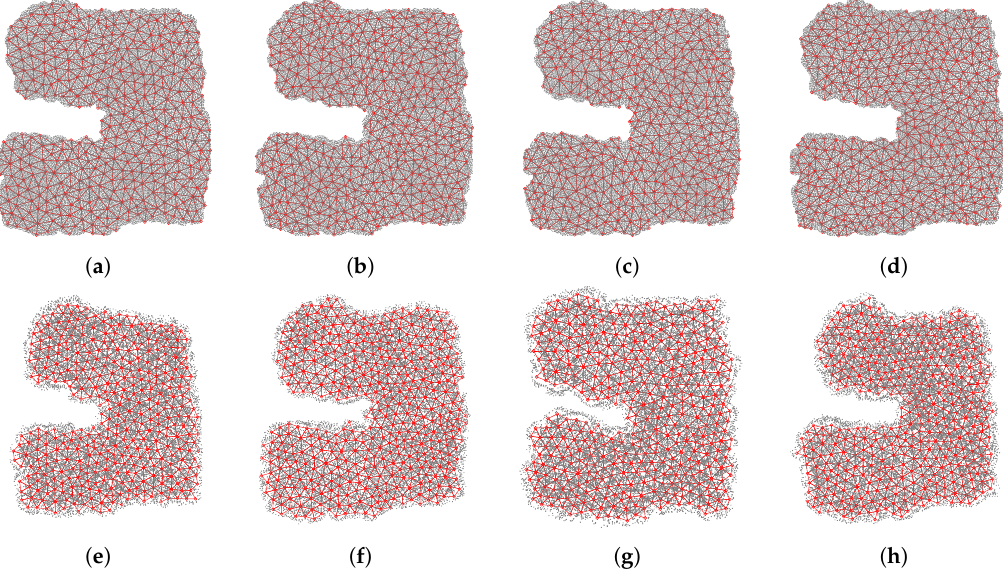
Figure 6. Networks with different transmission models: ( a – d ) the original networks with different transmission models that result in different nodal degrees and constructed triangular meshes; ( e – h ) the embedding results of our algorithm. All of the networks have the same number of nodes and the same communication range. ( a ) Unit disk graph (UDG) model with transmission range of one and localization error 0.25 in ( e ); ( b ) Quasi-UDG model with α = 0.75 and ρ = 0.5 and localization error 0.34 in ( f ); ( c ) log norm model with µ = 0.5 and ρ = 4 and localization error 0.42 in ( g ); ( d ) probability model with p = 0.65 and localization error 0.43 in ( h ).